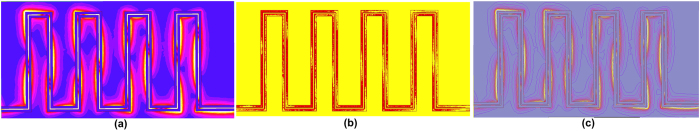
The simulated electrical-field distribution on the cross-section of conventional on-chip T-line coupler in 65 nm CMOS technology at 300 GHz, and the width of T-line is 5 μm while the lines spacing is 2.4 μm as well.The excitation configuration is the same as SPP T-line coupler; (b) the simulated magnitude of body current density (Jvol) distribution along the two conventional on-chip T-lines at 300 GHz, and (c) the simulated E-field lines distribution on the cross-section of conventional on-chip T-line coupler at 300 GHz.